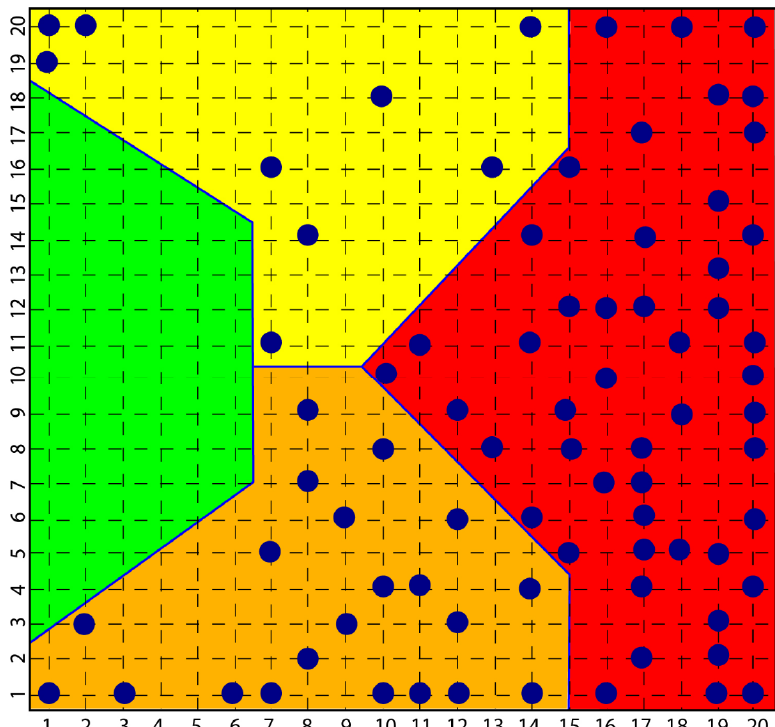
Figure 1. Figure shows how all subjects with psychopathology are distributed among the yellow, orange and red areas and none in the green area that classified normal subjects. Int. J. Mol. Sci. 2022 , 23 , x FOR PEER REVIEW